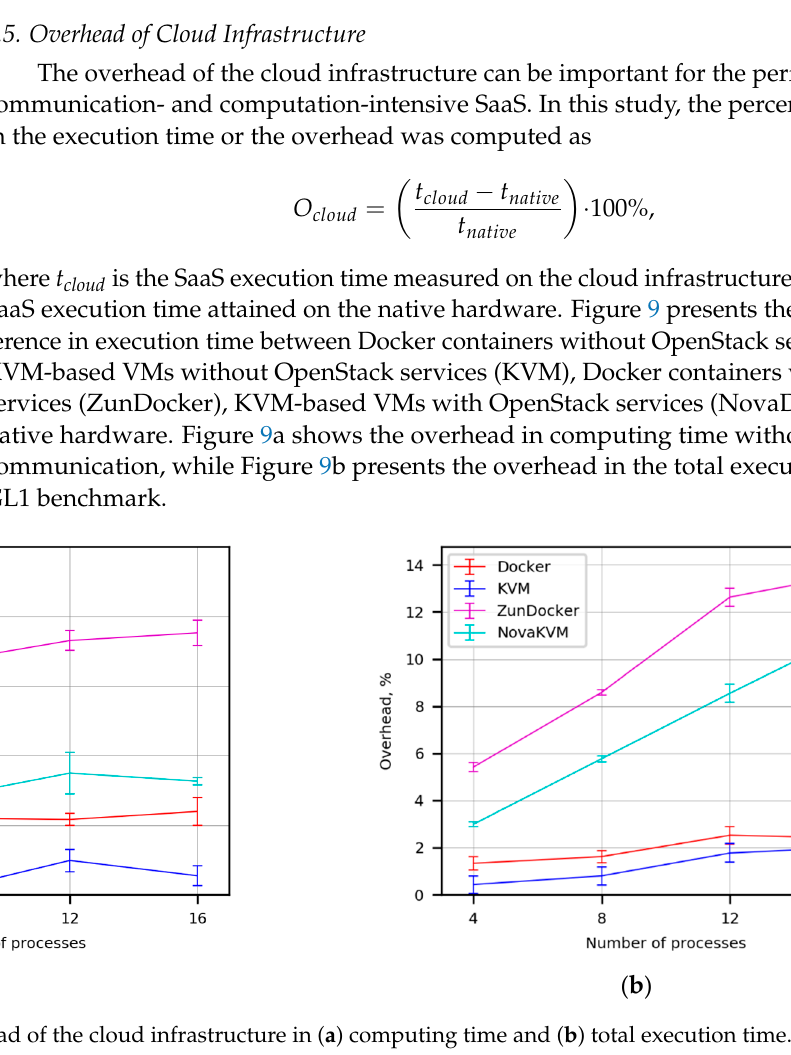
Figure 8. Contribution of computation, communication, and waiting to the benchmark execution times.